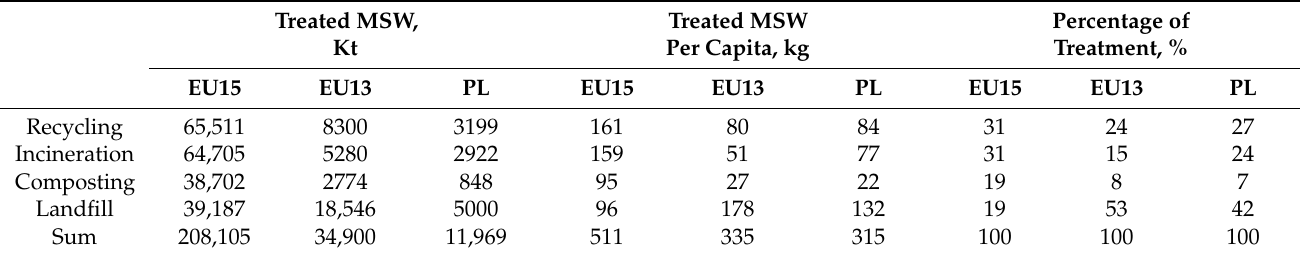
Table 1. Statistics for treated municipal waste in the EU15, EU13, and Poland (PL) [1]. Treated